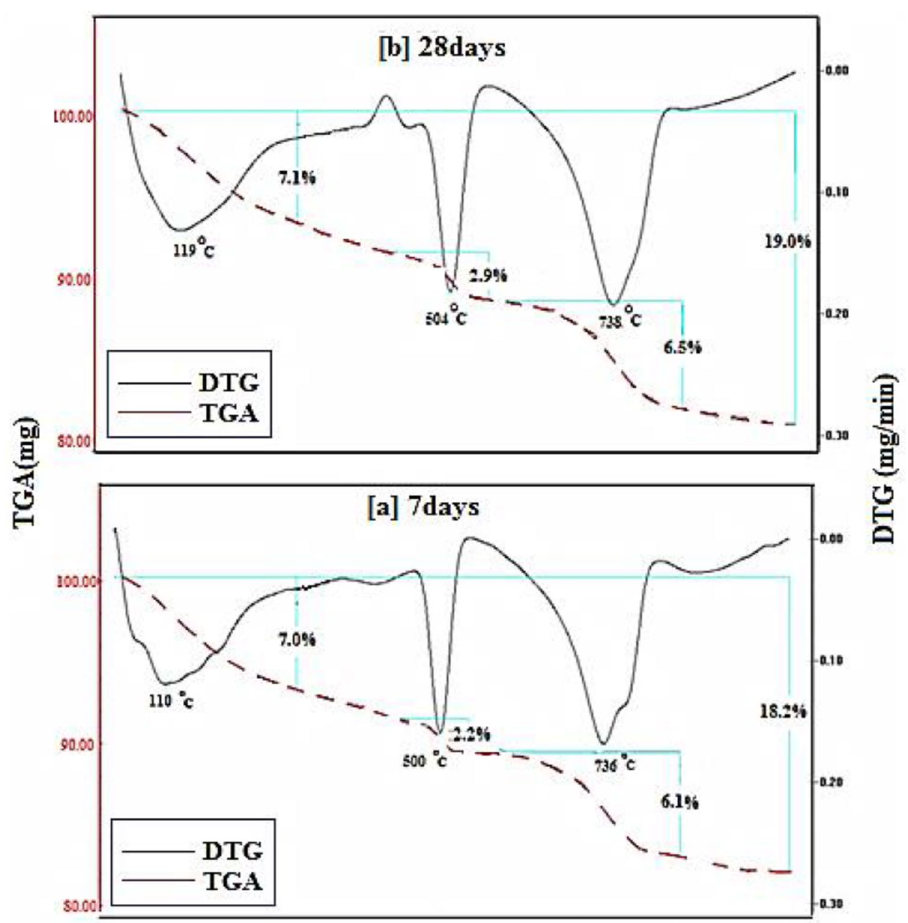
Figure 17. TGA/DTG thermograms of hardened specimens made from mix C ( a ) 7 days and ( b ) 28 days